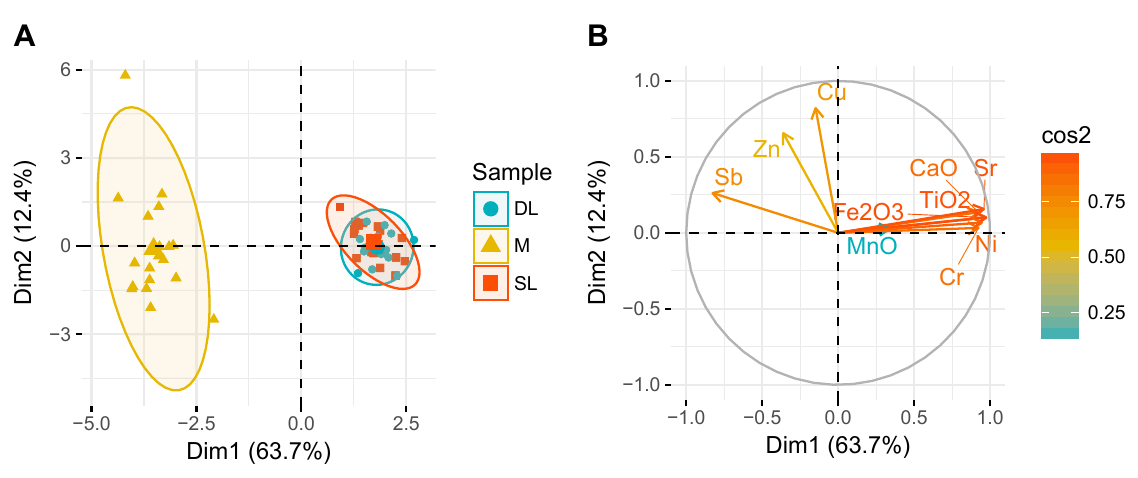
Fig. 7 Graphical representation of principal component analysis. ( A ) Ordination graph of the first two principal components. Ellipses are drawn around the 95% confidence interval for each sample group centroid. ( B ) Correlation circle between a vari- able and a principal component (PC). The cos2 value indicates the quality of representation of the variable on the principal component. M – mushroom samples; SL – surface soil samples; DL – deep soil